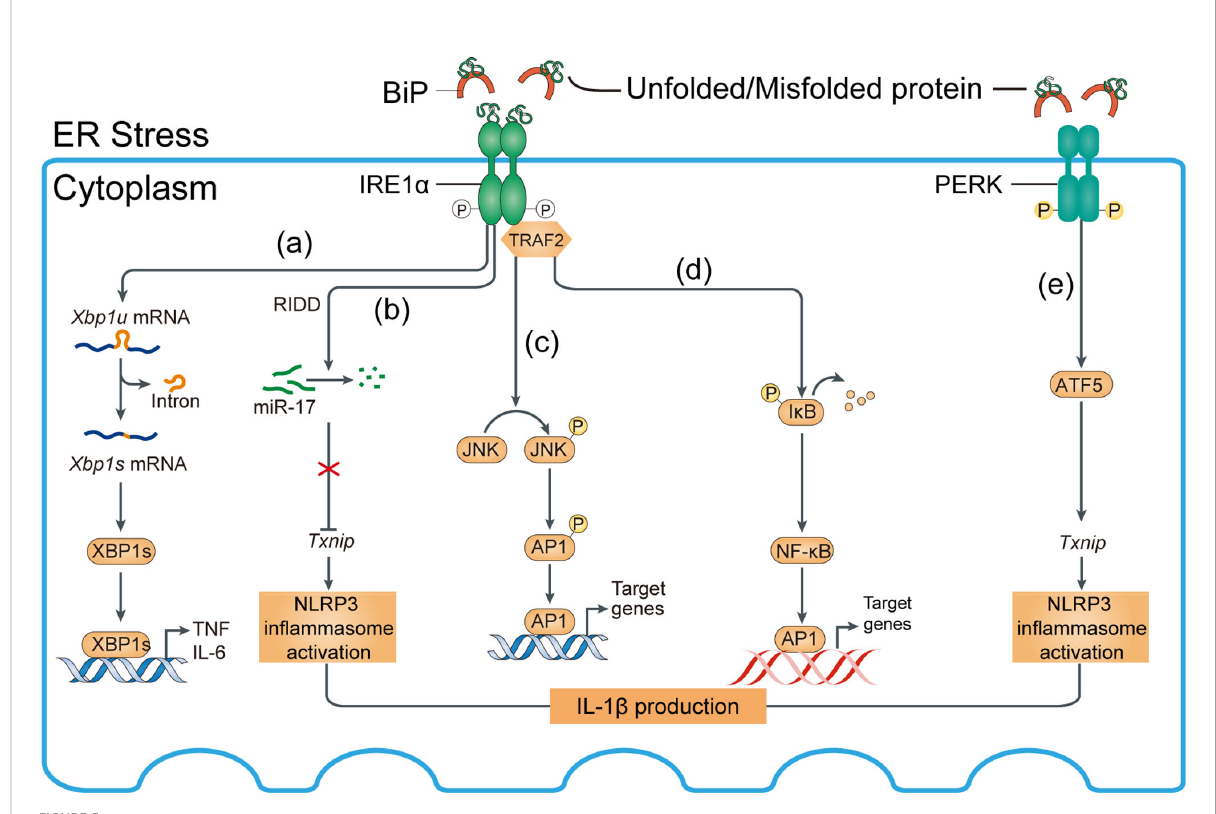
FIGURE 5 Mechanisms of ER stress-induced in fl ammation. Inositol-requiring enzyme 1 a (IRE1 a ) and PKR-like ER kinase (PERK) activation induce in fl ammasome activation. (A) IRE1 a activation and subsequent splicing of X-box binding protein 1 (Xbp1) produces the transcription factor XBP1s, which directly binds the promoters of tumor necrosis factor (TNF) and interleukin-6 (IL-6). (B) Regulated IRE1 a -dependent decay (RIDD)- dependent degradation of miR-17, which in unstressed conditions represses thioredoxin-interacting protein (Txnip), increases the Txnip level, NLRP3 in fl ammasome activation, and IL-1 b expression. (C) Activated IRE1 a forms a complex with TNF receptor-associated factor 2 (TRAF2) to induce phosphorylation of Jun N-terminal kinase (JNK) and upregulation of proin fl ammatory genes via activated activator protein 1